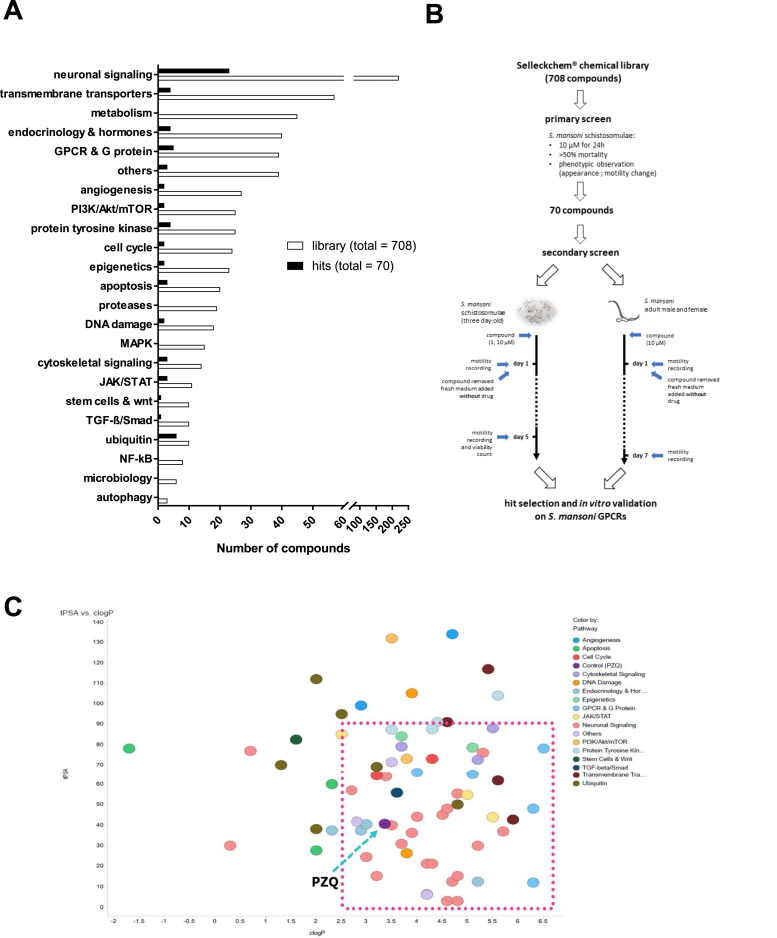
Compound screening workflow from a customized Selleckchem® drug library. (A) Distribution of the whole compound library (top pie chart) and the primarily selected compounds (bottom pie chart) per reported functional pathway. (B) Stepwise schematic of compound screening and hit selection based on phenotypic observation and motility recording of compound-treated S. mansoni schistosomulae and adult stages (C) Compound analysis in Spotfire: Plot of tPSA vs cLogP of compounds screened from Selleckchem® library.